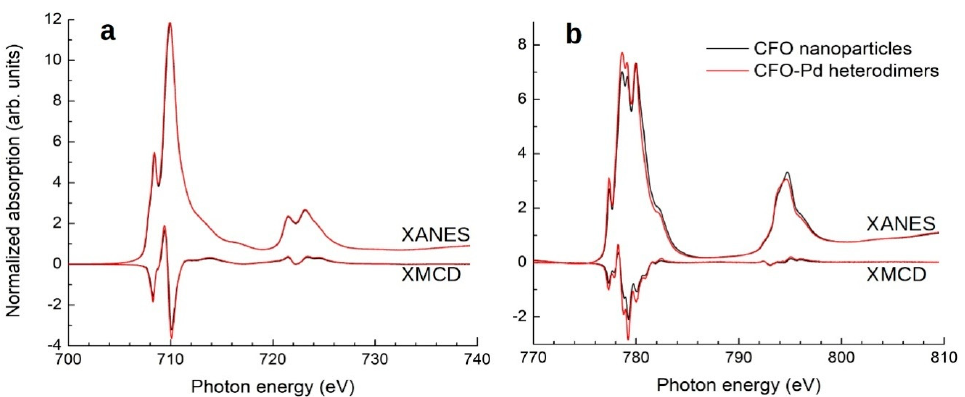
Figure 8. X-ray absorption near-edge structure (XANES) and magnetic circular dichroism (XMCD) of bare CoFe 2 O 4 nanoparticles (CFO, black lines) and after Pd decoration (CFO-Pd, red lines). Measurements were performed at 5 K in a magnetic field of 6 T at the Fe L 3,2 absorption edges ( a ) and Co L 3,2 absorption edges ( b ).